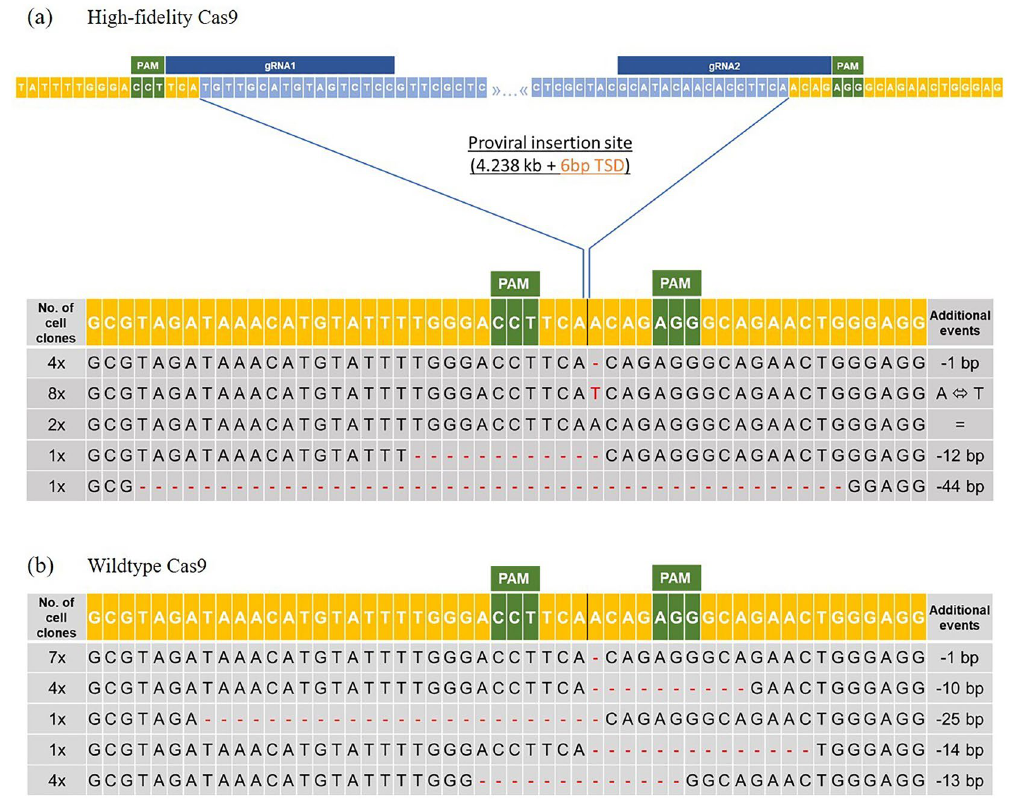
Figure 2. CRISPR/Cas9-mediated deletion events at the blue egg locus in Araucana crossbreed chicken PGCs. Yellow: Chromosome 1, light blue: EAV-HP retrovirus sequence, orange: 6 bp target-site duplication (TSD), PAM protospacer adjacent motif (green), dark blue: guide RNA. ( a ) Sanger sequencing of 16 single PCR clones (1F/2R) with deletion of the provirus insertion. Results are based on co-transfection of PGCs with gRNA1 and gRNA2 using a high-fidelity variant of the Cas9 endonuclease; ( b ) Sanger sequencing of 17 single PCR clones (1F/2R) with deletion of the provirus insertion. Results are based on co-transfection of PGCs with gRNA1 and gRNA2 using the standard Cas9